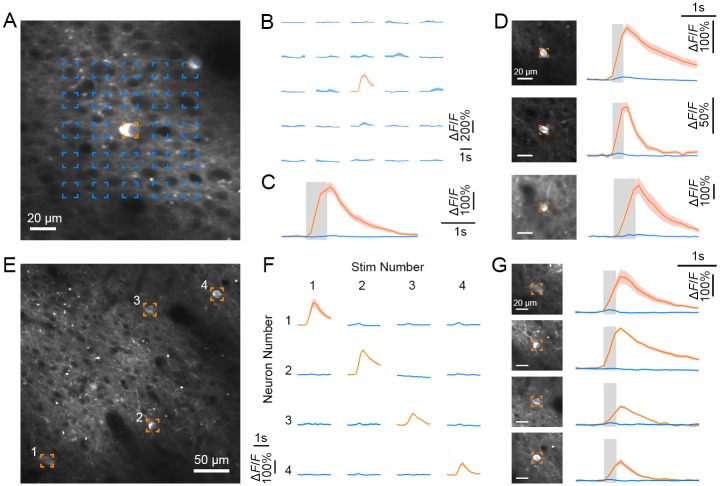
AOI with single-cell resolution in V1.(A) 2P image of a targeted neuron co-expressing GCaMP5G and C1V1 (orange box, on Day 400 at 161 μm). (B) Calcium responses of the targeted neuron following spiral 2P optogenetic stimulation at each of the 5 × 5 grid locations from (A). The target neuron responded only to directly focused 2P stimulation, indicating that 2P stimulation is spatially precise. (C) Average fluorescence traces from the neuron when targeting 2P stimulation directly at the soma (orange) versus the surrounding parenchyma (blue; mean ± s.e.m., n = 15 trials). (D) Fluorescence traces of three other neurons under 2P stimulation (first two on Day 570 and third on Day 400). (E) 2P image containing four targeted neurons co-expressing GCaMP5G and C1V1 (on Day 570 at 189 μm). (F) Calcium responses of the targeted neurons (from E) when they were sequentially activated with spiral 2P stimulation. Each row demonstrates one of four neurons’ activity (numbered as in E) during stimulation on either the same or alternate numbered neuron (columns). (G) 2P images of the targeted neurons (E) and their individual average fluorescence traces when each of them was targeted (orange) versus not targeted (blue; mean ± s.e.m., n = 10 trials). Data can be found at https://github.com/EastRainju/Opto-TP. 2P, two-photon; AOI, all-optical interrogation; C1V1, ChR1/VChR1; GCaMP, genetically encoded calmodulin protein; V1, primary visual cortex.